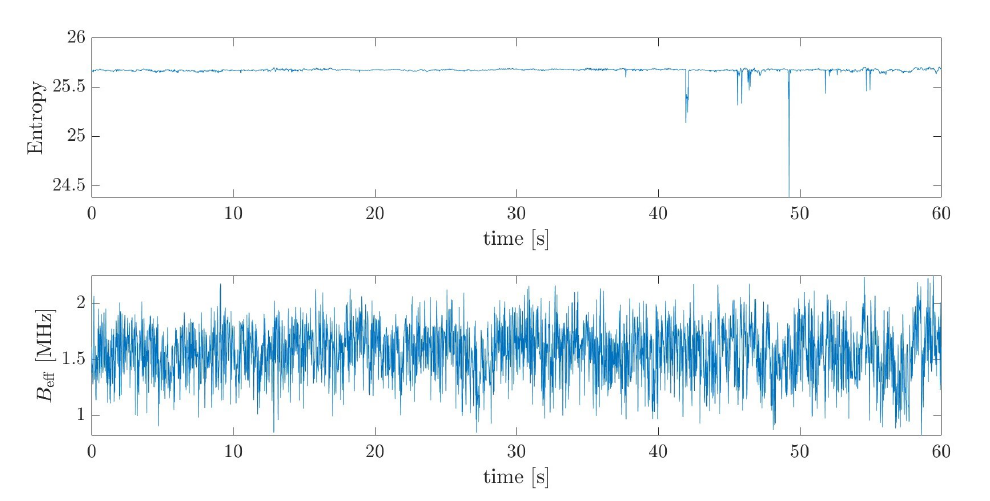
Figure 24. Entropy and effective bandwidth values obtained for consecutive 20 ms fragments across 60 s of